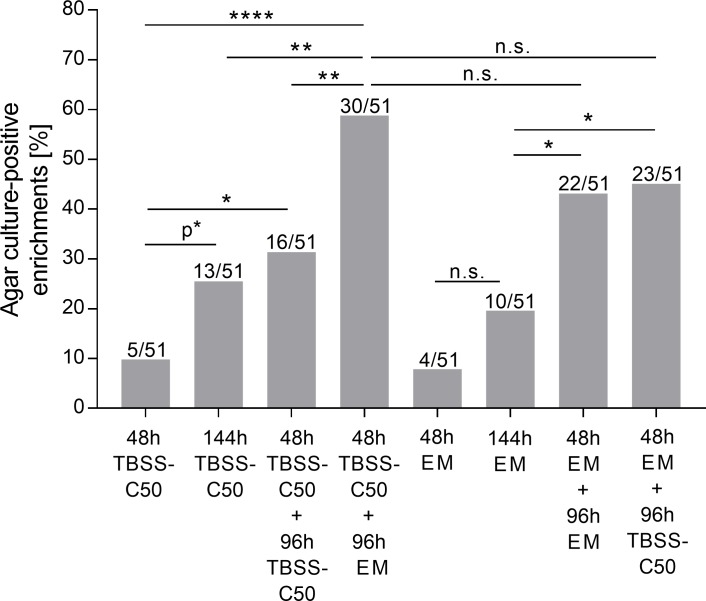
Impact of the various enrichment methods on the number of B. pseudomallei culture positive samples on Ashdown agar.All supernatants of the 51 samples with a positive qPCR signal in at least one of the enrichments (408 supernatants) were subcultured on Ashdown agar. The percentage of Ashdown agar culture-positive enrichments among all 51 samples is shown as grey bars for each culture condition. The total number of B. pseudomallei culture-positive samples in the respective culture condition is written above the corresponding bar. Statistical analyses were performed using the Fisher's exact test (*p<0.05; **p<0.01; ****p<0,0001, p* = 0.067).